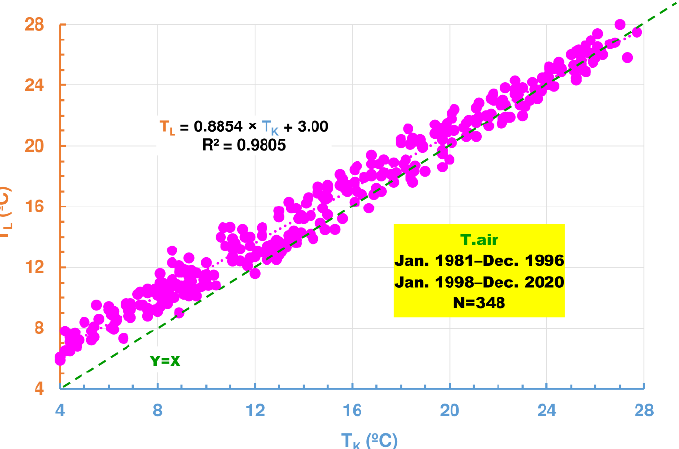
Figure 4. Histograms of the average values of the mean monthly air temperatures at Lastovo (brown) and Krk (blue) and their differences (red) in the period 1981 – 1986 and 1998 – 2020. From the ratio of mean monthly air temperatures of Lastovo (ordinate axis) and Krk